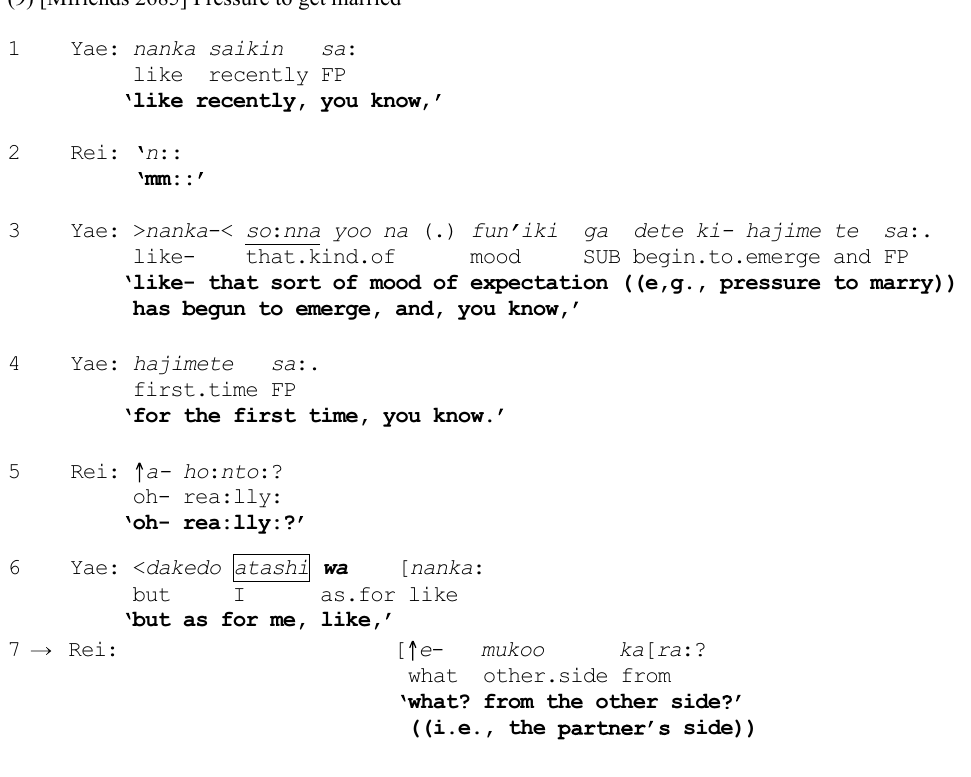
bothersome} vs. {people who find carefree behavior lovable} (left) , whereas Mari invokes the MCD defined by the binary opposition {carefree people} vs. {attentive people} (right)